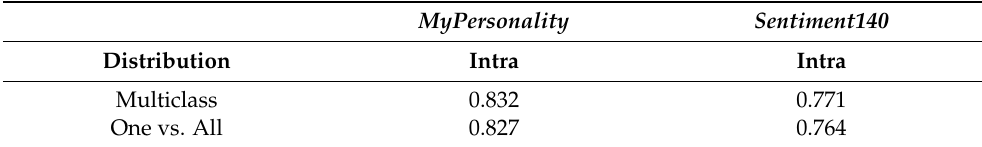
Table 5. Cosine similarity of SLDA